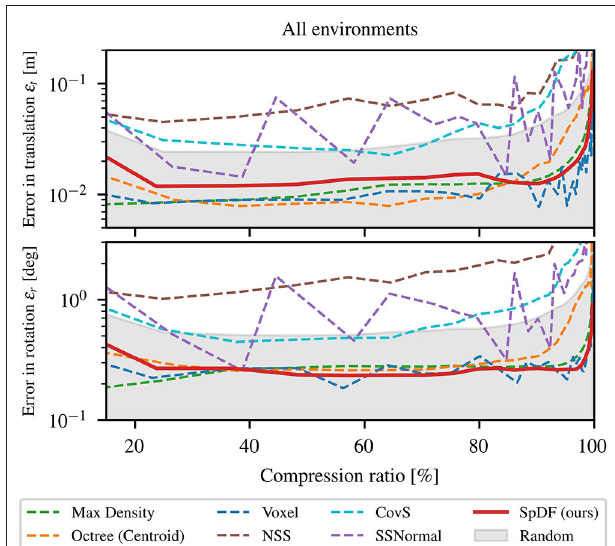
FIGURE 5 | Influence of the number of points (i.e., compression ratio) on the registration process for all environments concatenated. The gray area represents the errors less than the baseline. SpDF (ours) is displayed in solid-line. The top-graph represents the error in translation ε t in m; The bottom-graph represents the error in rotation ε r in deg. Both translation and rotational errors show the same patterns. Only spatial methods ( Voxel and Octree ) and density-based methods ( MaxDensity and SpDF (ours)) outperform the baseline, providing a translation error less than 2cm, and a rotation error of less than 0.3 ◦ , which tend to the minimal reachable errors for the ICP